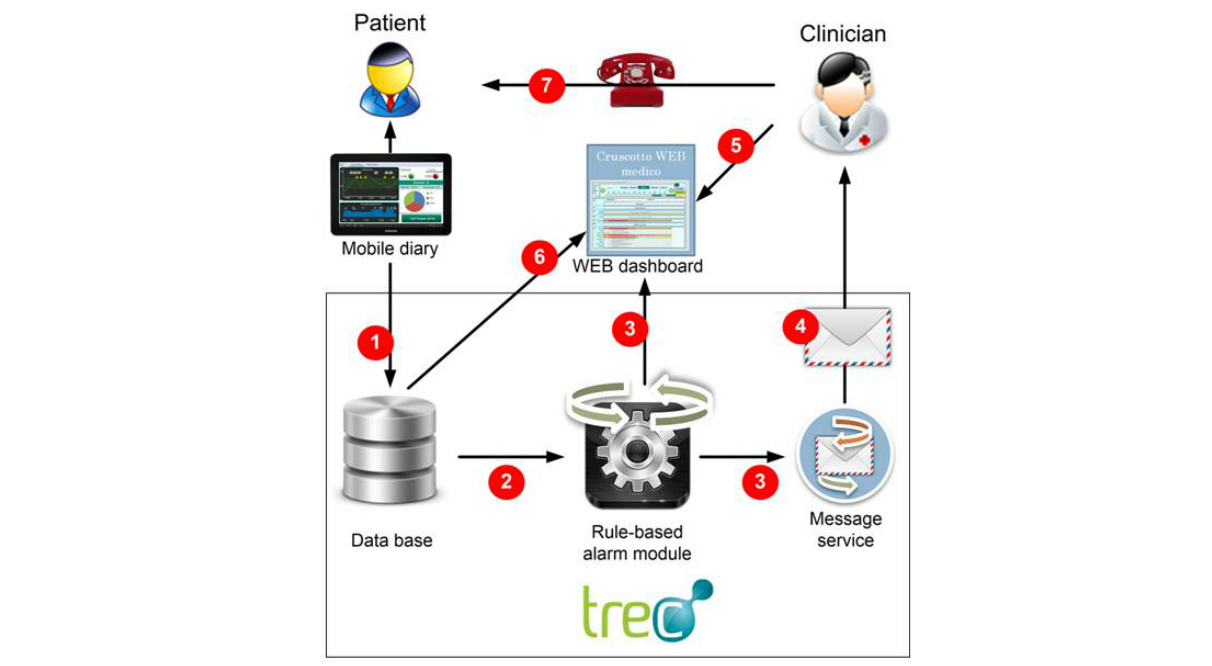
Figure 5. Conceptual model of cancer patient home monitoring: (1) diary compilation - data are stored in central database and displayed on dashboard; (2) real- time analysis by rule-based alarm module; (3) If “critical event” is detected, alarm signal is automatically generated and displayed on dashboard; (4) message service alerts competent health professional; (5) doctor/nurse accesses patient dashboard to evaluate patient’s problems; (6) dashboard shows patient’s data and alarms; (7) they can contact patient directly if